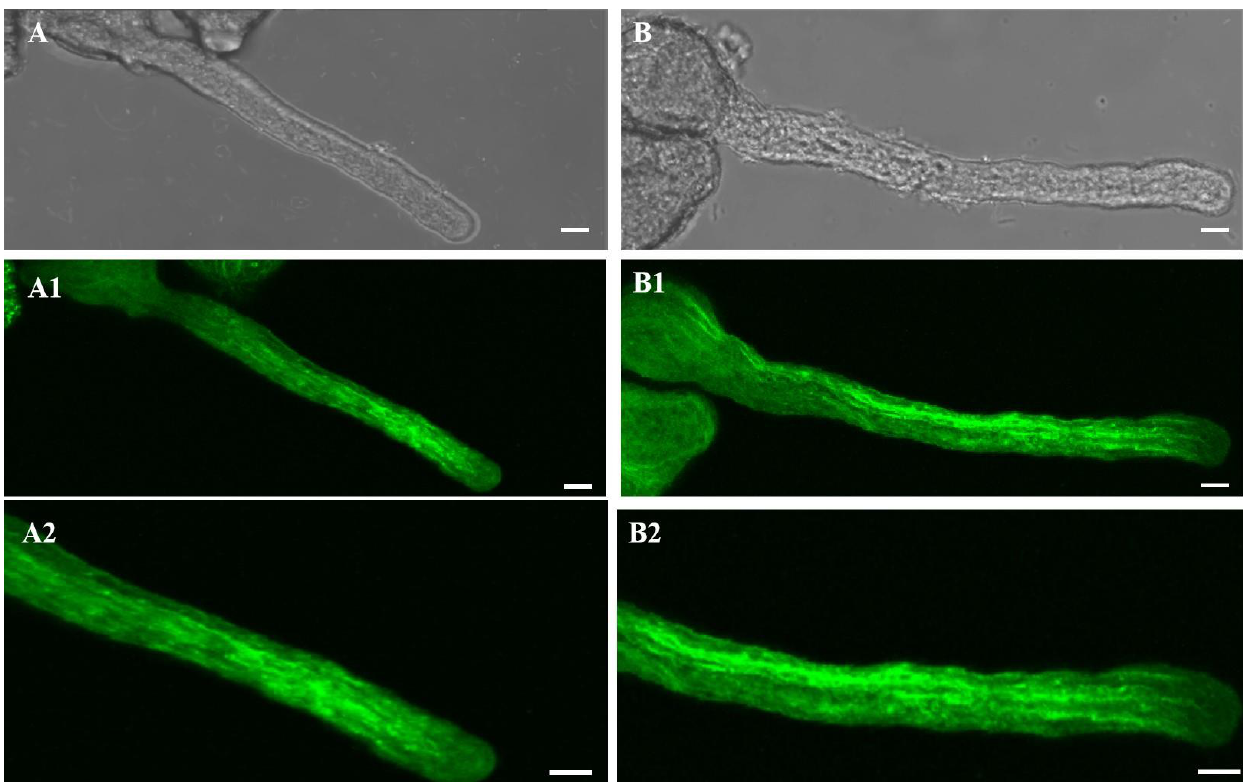
Figure 3. Effect of 20 µM AlCl 3 on actin filaments of pollen tubes of M. domestica. ( A ) Bright-field image of a control pollen tube. ( A1 ) Actin filaments of the pollen tube in A, labeled with 0.2 µ M phalloidin-FITC under CLSM. ( A2 ) Larger magnification of A1 . ( B ) Bright-field image of a pollen tube treated with 20 µM AlCl 3 . ( B1 ) Actin filaments of the pollen tube in B. ( B2 ) Larger magnification of B 1 . Bar = 10 µm.